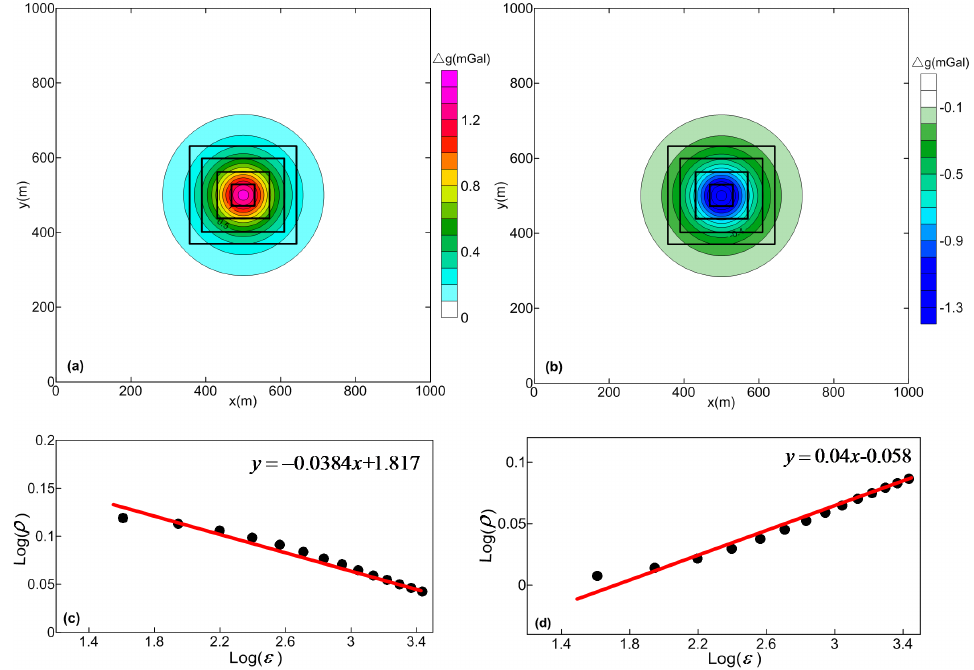
Fig. 1. The upper plots illustrate local singularity calculation of forward gravity anomalies produced by (a) high- and (b) low-density spheres. The log–log plots illustrate the relationship between the concentration values ρ(ε) and the box size ε , centred at the (c) high- and (d) low- density spheres.